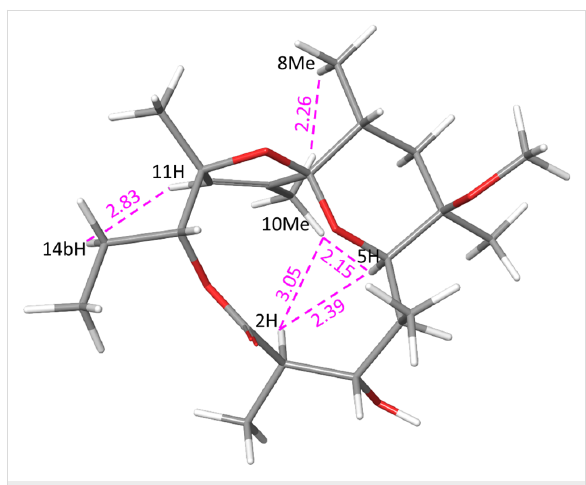
Figure 4: Modelling-derived structure of 3 showing key nOe interac- tions (calculated distances in Å).